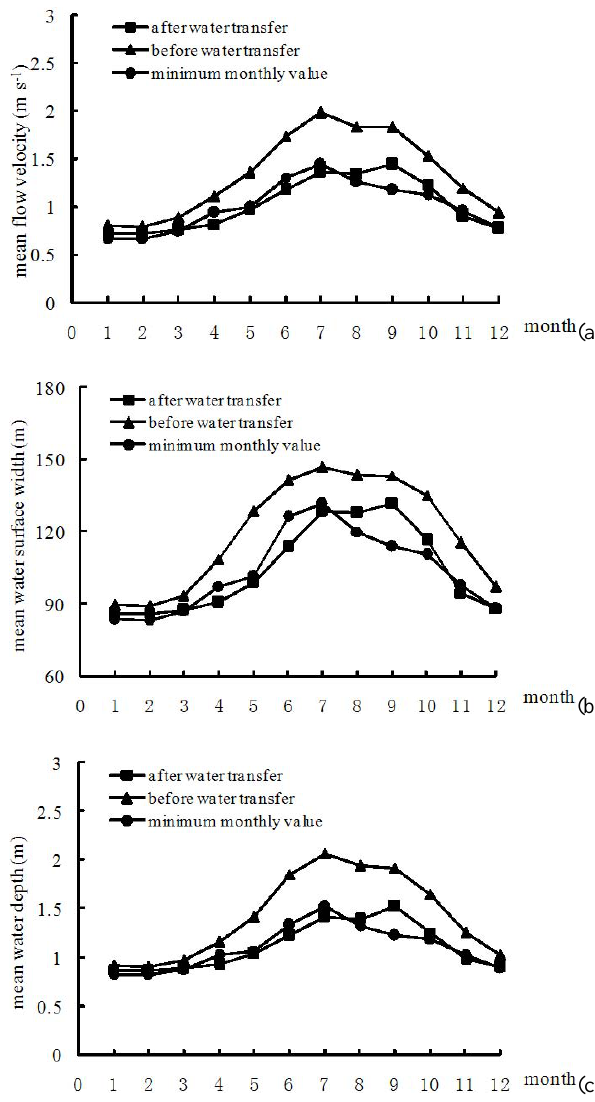
Fig. 7. Influence on the average flow velocity, water surface width and water depth at the Ganzi section of Yalong River. (a) Mean flow velocity, (b) mean water surface width and (c) mean water